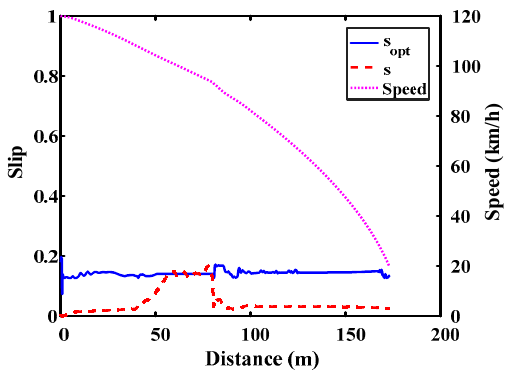
Figure 14. Optimum slip, real slip and speed.